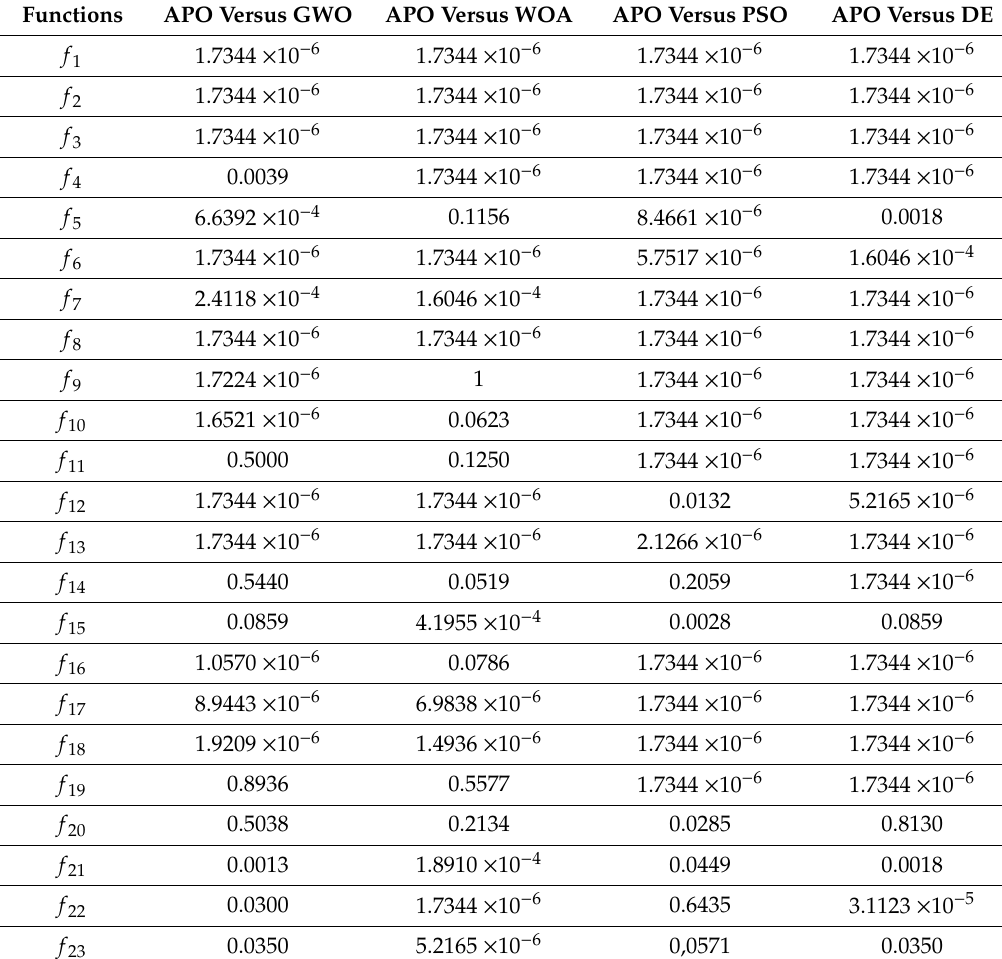
Table 7. The results of Wilcoxon signed ranks test based on the solution for each benchmark with 30 independently